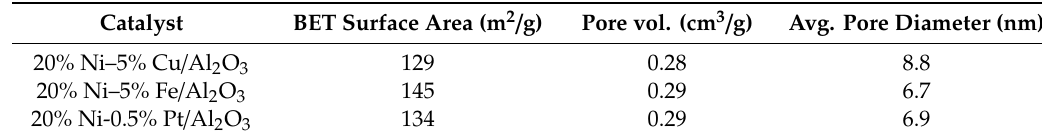
Table 1. Textural properties of the catalysts studied.